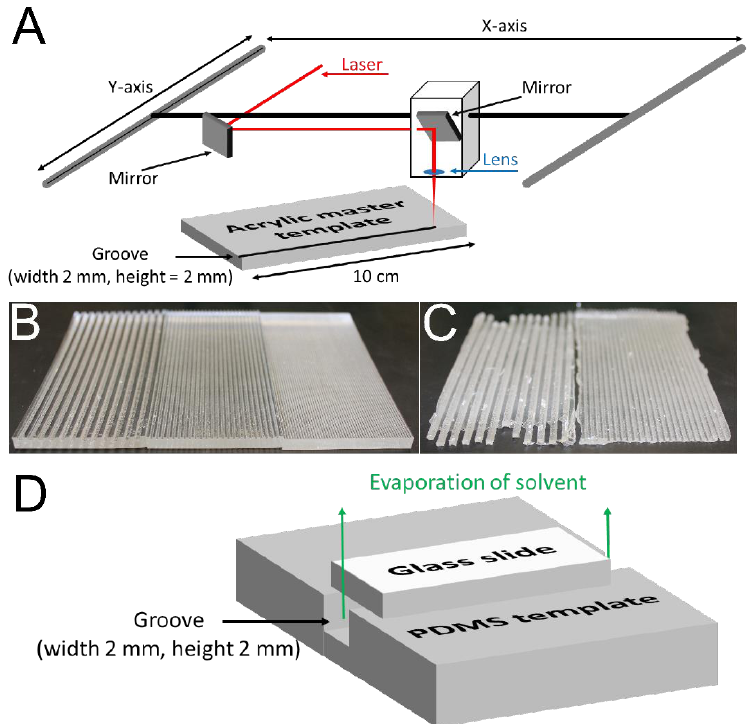
Figure 2. ( A ) Illustration of the experimental setup used to produce the hard acrylic master template with grooves with widths and heights of 2 mm. ( B ) Examples of the hard acrylic master templates produced: ( left ) grooves with widths and heights of 2 mm; ( center ) grooves with widths and heights of 1 mm; ( right ) grooves with widths and heights of 0.5 mm. ( C ) Examples of the flexible PDMS templates produced: ( left ) grooves with widths and heights of 2 mm; ( right ) grooves with widths and heights of 1 mm. ( D ) Illustration of